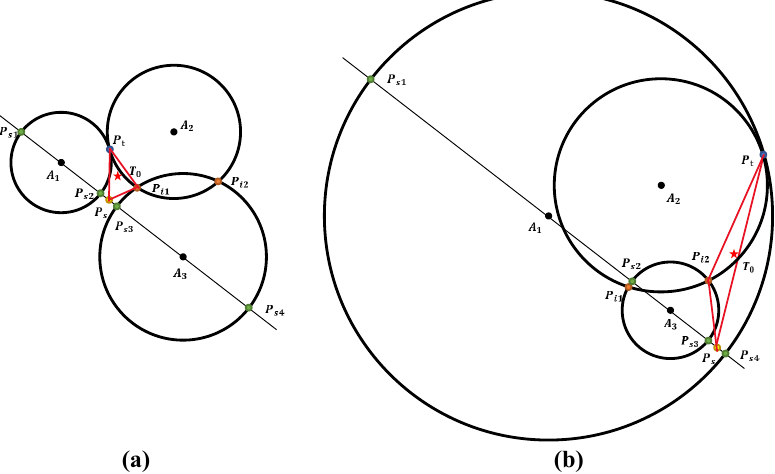
Figure 10. The special case in the TCPA where the three circles do not intersect at a point. The triangle formed by the red line segment is the triangle selected by the trilateral centroid positioning algorithm, and the red five-pointed star is the centroid of the triangle, which is also the positioning result. ( a ) Circle A1 and circle A3 are outer separated. ( b ) Circle A1 and circle A3 are inner separated.